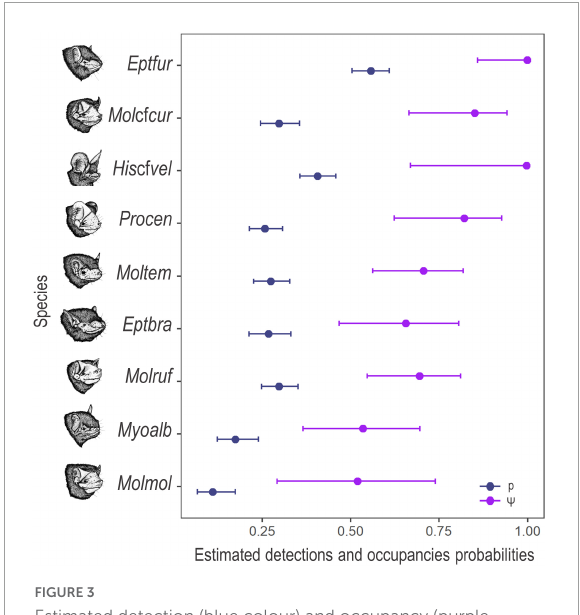
FIGURE3 Estimated detection (blue colour) and occupancy (purple colour) mean probabilities and 95% confidence interval for the nine species of bats, recorded in the Brazilian Pampa during the spring and summer of 2019 and 2020. Eptesicus furinalis ( Eptfur ), Molossus cf. currentium ( Mol cf cur ), Histiotus cf. velatus ( His cf vel ), Promops centralis ( Procen ), Molossops temminckii ( Moltem ), Eptesicus brasiliensis ( Eptbra ), Molossus rufus ( Molruf ), Myotis albescens ( Myoalb ), and Molossus molossus ( Molmol